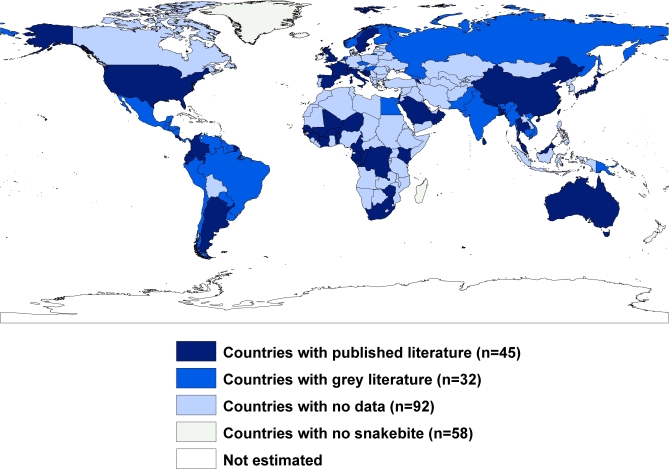
Countries with Data on Snakebite Envenoming